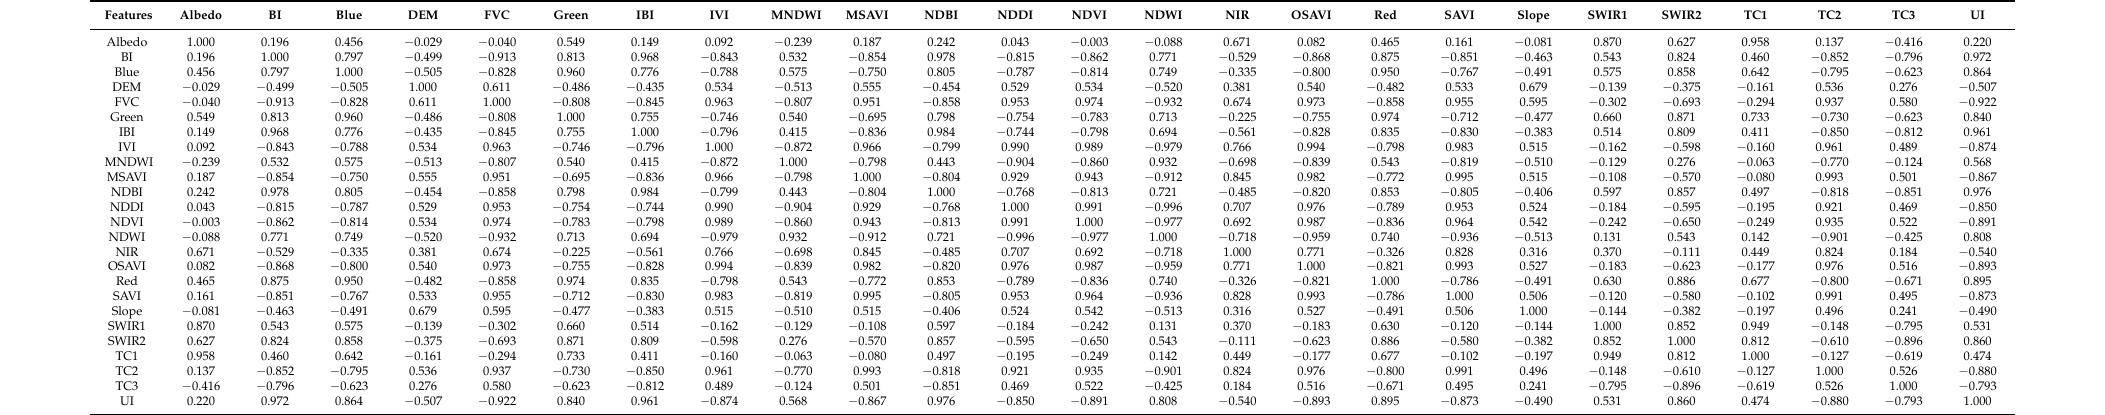
Table A1. Pearson correlation coefficient matrix among the candidate